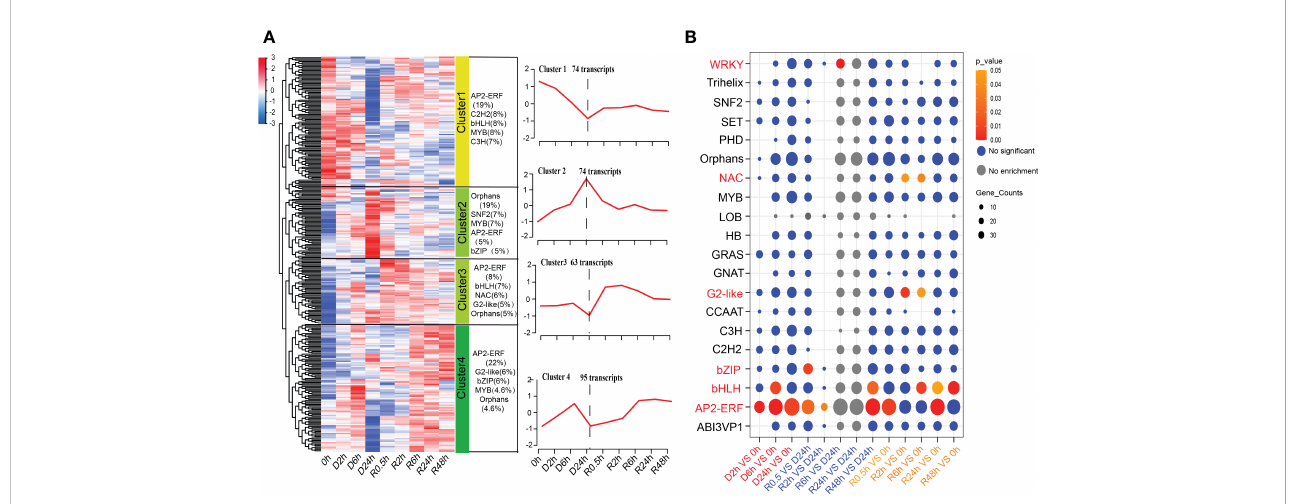
FIGURE 6 Global transcript abundance pro fi ling and enrichment analysis of TFs during D-R process. (A) Heatmap and the dynamic accumulation patterns of the TFs; FPKM values are used for the heatmap and Clusters, (Cluster 1-Cluster 4) were generated by the K-means. The category and number of transcripts are marked in the upper part of each line chart. (B) Enrichment analysis of TFs in different comparison pairs. Circle size is correlated with number of TFs. TF family names are listed on the left, and different comparison pairs are listed on the bottom; red and orange circle represent p ≤ 0.05, bule circle represent no signi fi cant, grey circle indicated no enrichment; Treatments during 24 h of desiccation (D h) and 48 h of rehydration (R h).